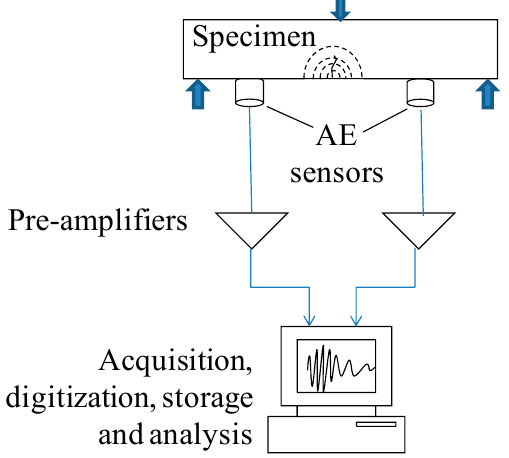
Figure 1. Typical acoustic emission (AE) setup.